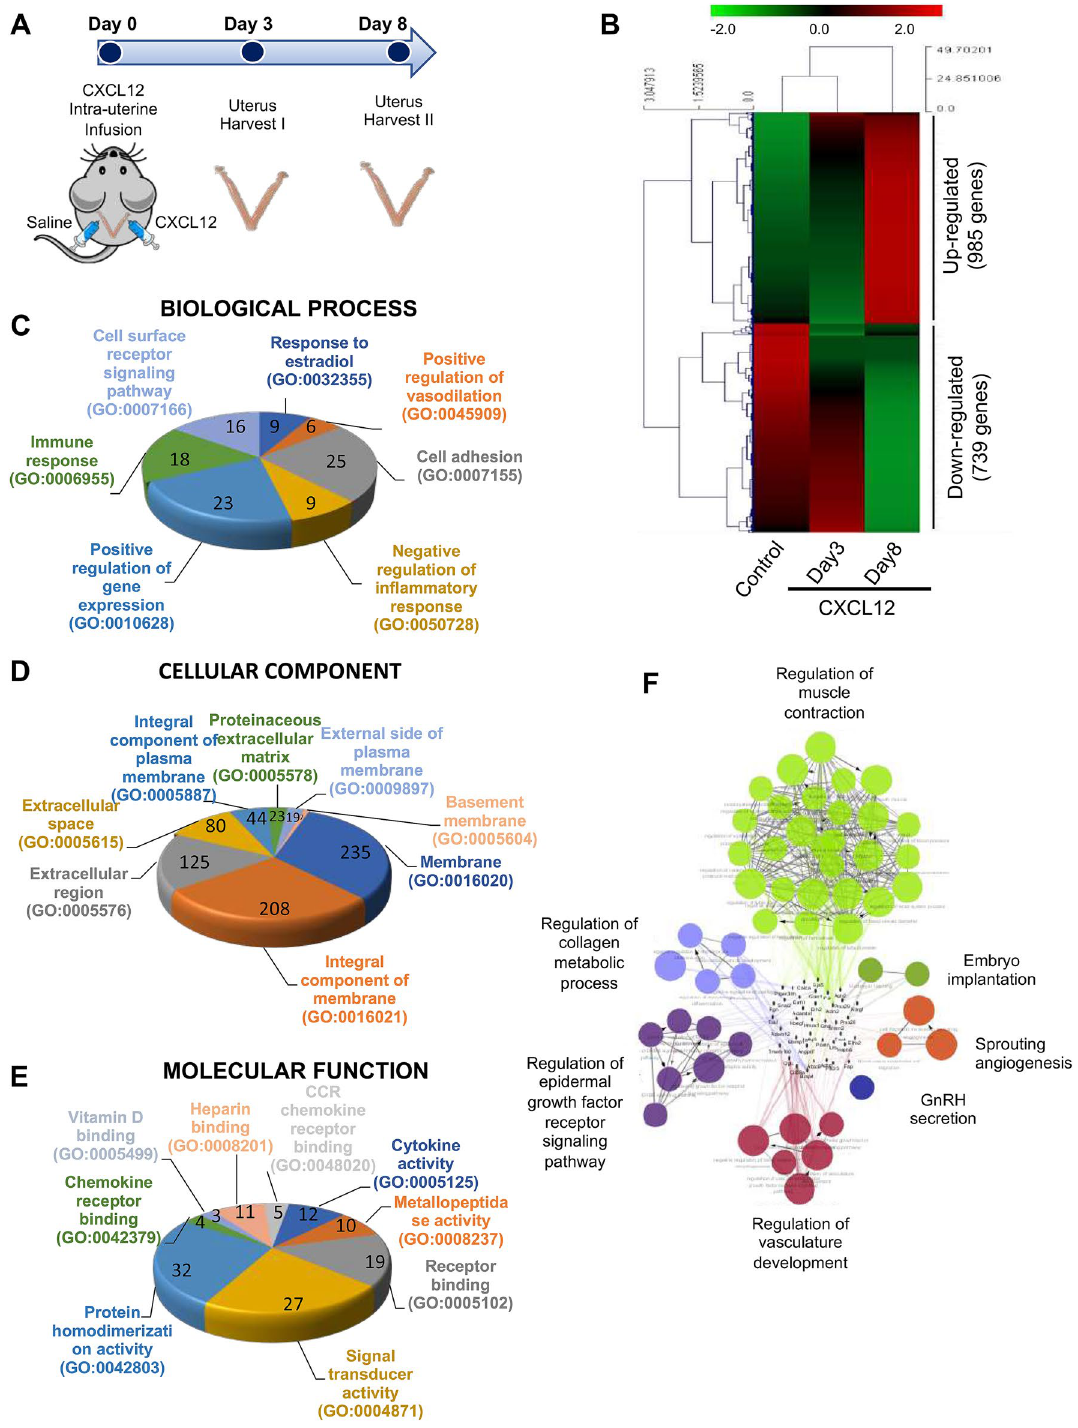
Figure 3. Identification of differentially expressed genes between the CXCL12-treated uterus versus control. ( A ) A schematic diagram of experimental plan of intrauterine CXCL12 administration. ( B ) Unsupervised hierarchical clustering analysis of RNA seq visualizing a heatmap plot showing differentially expressed genes (DEGs) in CXCL12- treated group vs control. Each row represents a distinct sample (6 independent CXCL12-treated groups compared to saline-treated control) and each column represents an individual gene (a list of 23,282 genes). Normalized (log2) and standardized (each sample to mean signal = 0 and standard deviation = 1) level of gene expression is denoted by color (green; low, dark; intermediate, red; high), as indicated in the gradient panel. ( C-E ) Pie charts displaying gene ontology (GO) and pathway analysis of differentially expressed genes between CXCL12-treated (Day 8) and control using DAVID tool and the numbers for gene count were indicated on each pie chart. The cutoff for significance was set by P < 0.05. ( C ) Biological Process (BP), ( D ) Cellular Component (CC), and ( E ) Molecular Function (MF). ( F ) A network of gene–gene interaction among CXCL12-regulated genes was constructed displaying specifically enriched signaling pathways